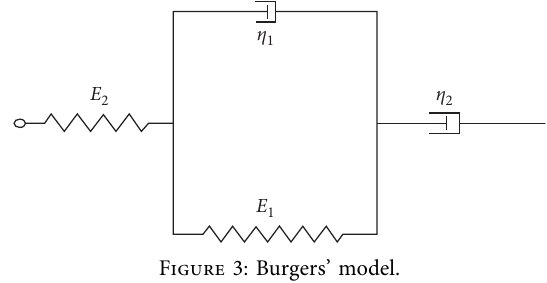
Figure 3: Burgers’